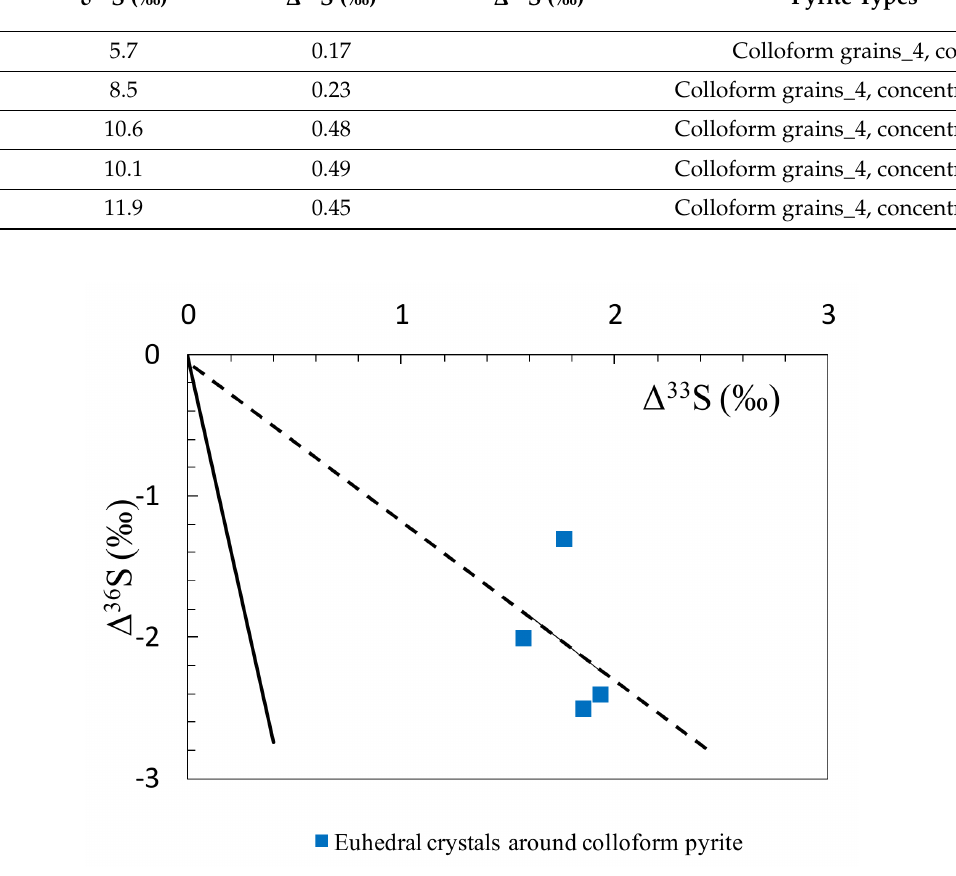
Figure A6. Plot of ∆ 33 S versus ∆ 36 S for the euhedral pyrite crystals from the sample, showing in Figure A4. The dashed line on the plot is a linear fit to data with a slope of − 1.15. Also shown is the solid line with a slope of − 6.85 for mass-dependent sulfur isotope fractionation in Phanerozoic samples, reported in [31]. Note that our data cannot be associated with microbial mass-dependent sulfur isotope